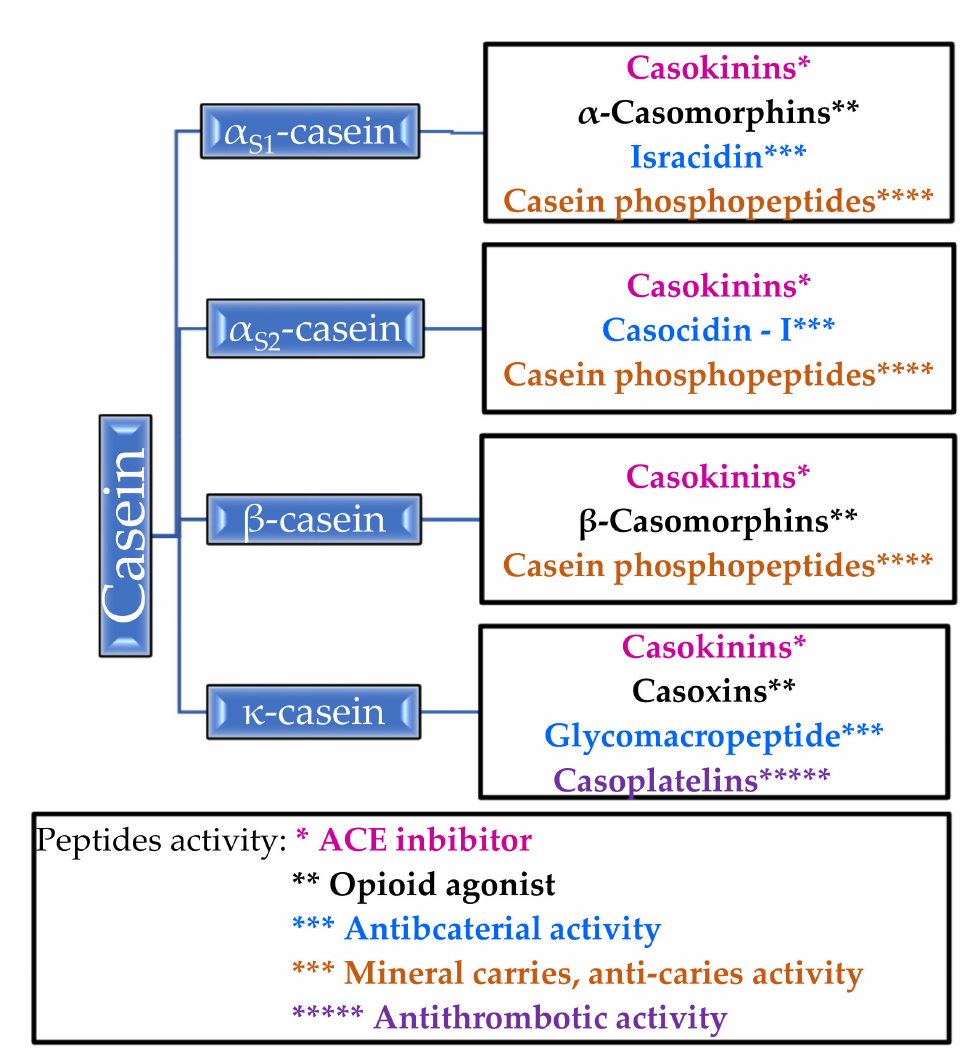
Figure 1. Peptides released from casein and their